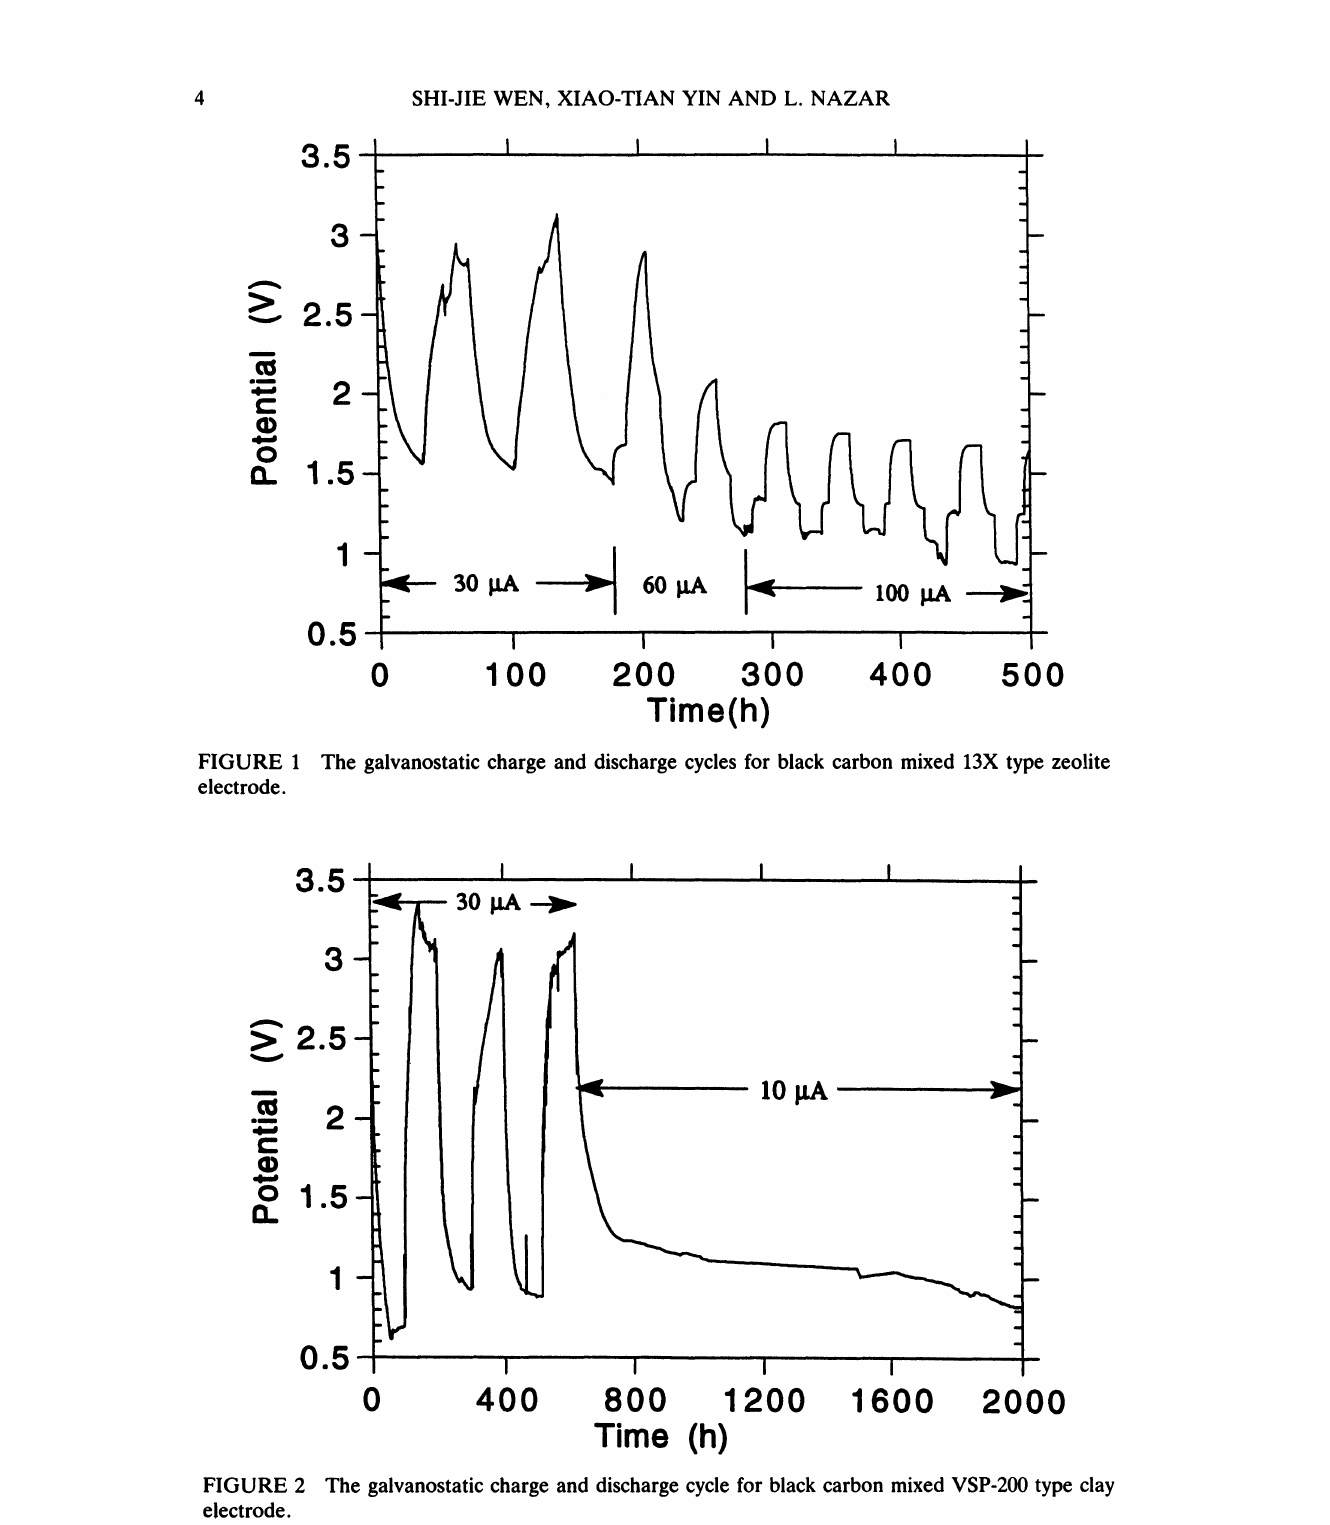
FIGURE 2 The galvanostatic charge and discharge cycle for black carbon mixed VSP-200 type clay